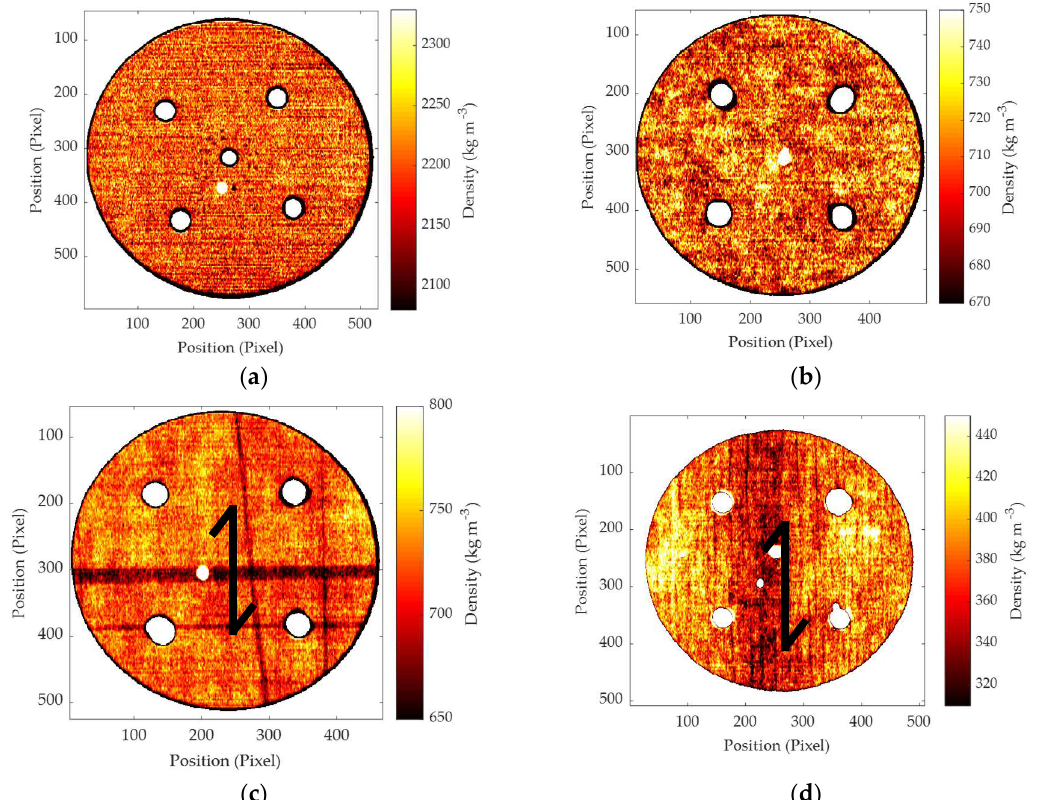
Figure 2. Densities of the machined samples measured by X-ray densitometry: ( a ) PTFE sample; ( b ) MDF sample; ( c ) beech-LVL sample; ( d ) poplar-LVL sample. Grain direction is reported for beech and poplar